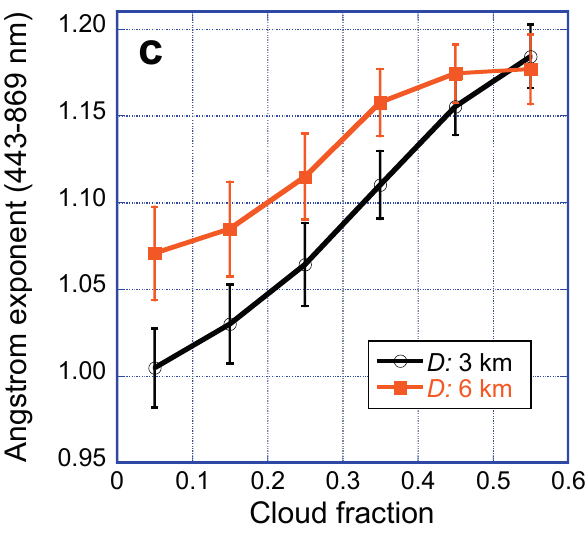
Figure 4. Impact of cloud fraction at two distances from clouds ( D = 3 km and D = 6 km ). All QA flags are used to screen the data except for the straylight flag. ( a ) Number of pixels; ( b ) aerosol optical thickness; ( c ) Angstrom